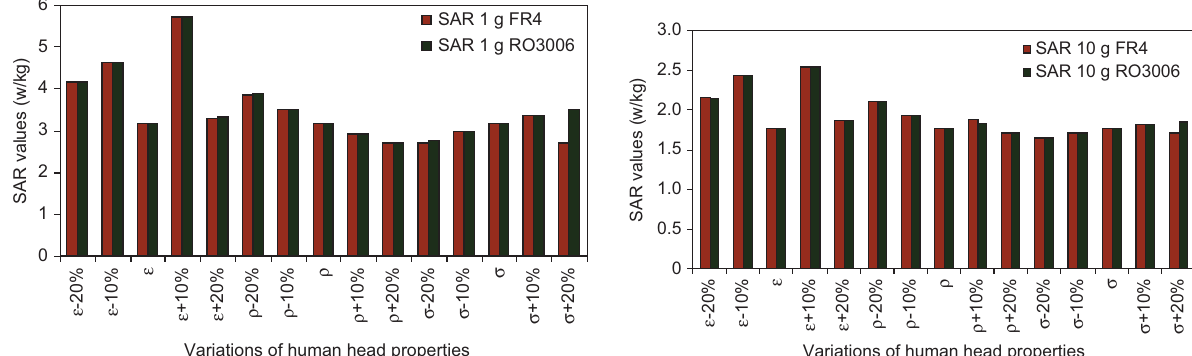
Figure 8 SAR 1 g of two different substrates at 1900 MHz.